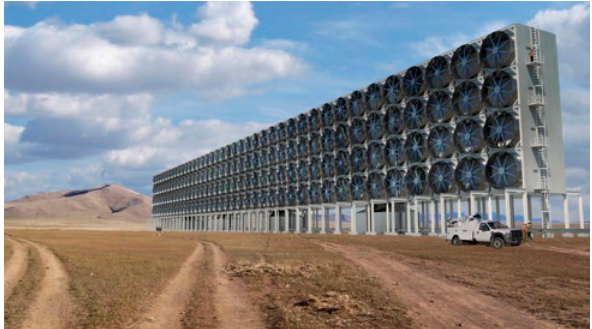
Figure 5. Proposed design to capture 1 million tonnes of CO 2 per year. Photo-illustration: courtesy of Carbon Engineering